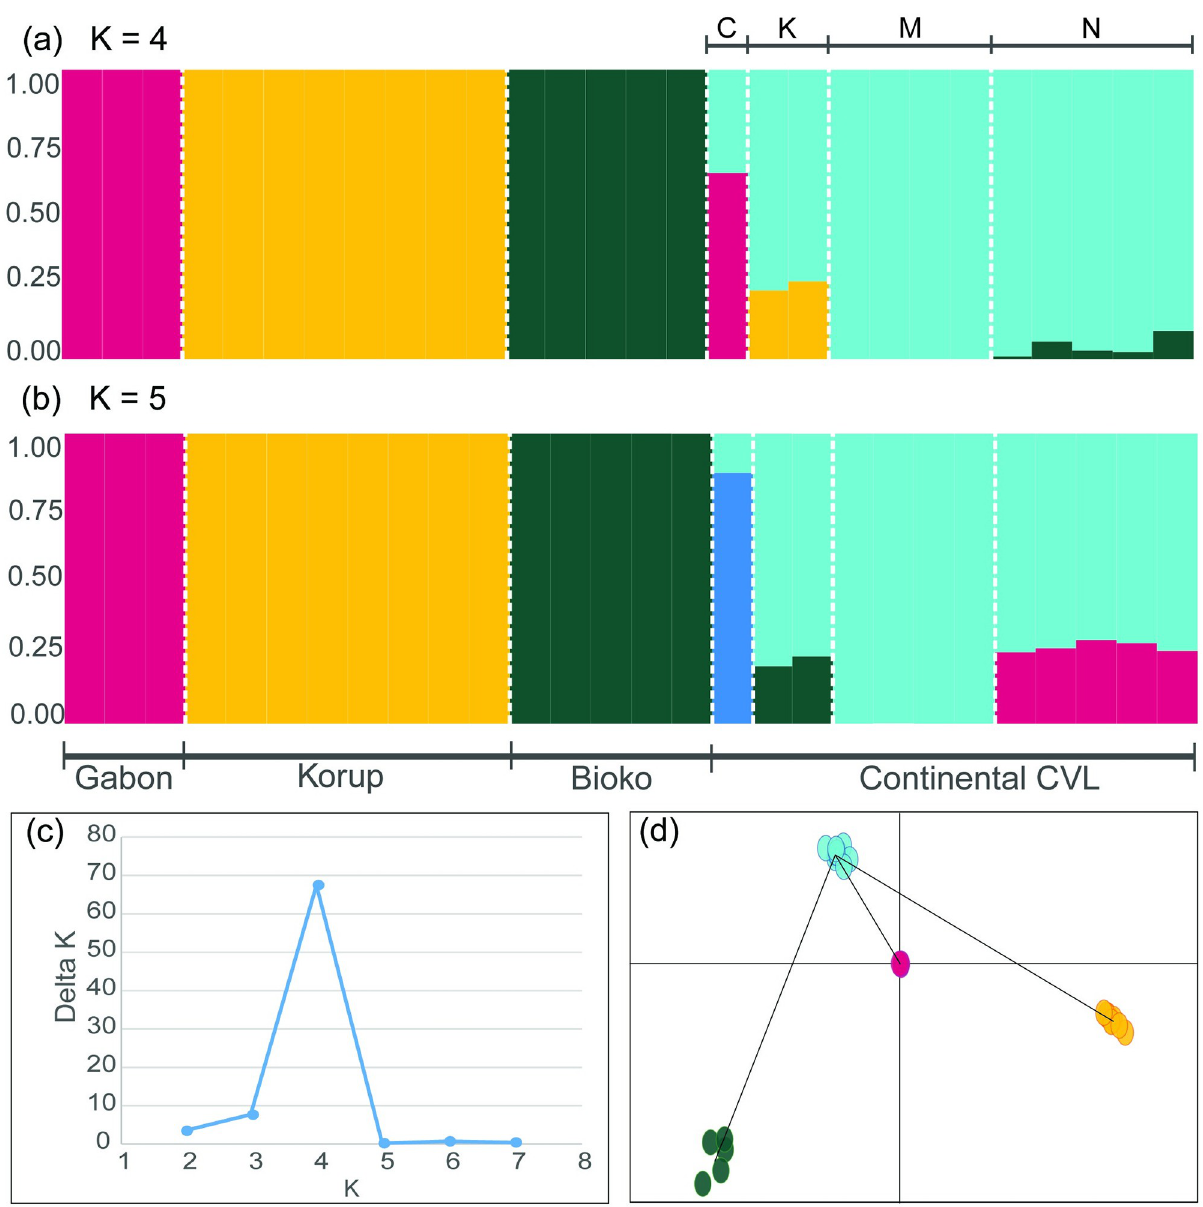
Fig 5. Bayesian cluster analysis using the STRUCTURE program for 28 Rhampholeon spectrum . (a) plot for K = 4, (b) plot for K = 5, (c) delta K from the structure analysis was calculated according to the method of Evanno from POPHELPER, and (d) a discriminant analysis of principal components using the program Adegenet. In (a) and (b), each bar corresponds to one sample of R . spectrum . C = Mt. Cameroon, K = Mt. Kupe, M = Mt. Manengouba, N = Mt. Nlonako, K = Number of populations, CVL = Cameroon Volcanic Line. The color scheme matches the sampling localities depicted in Fig